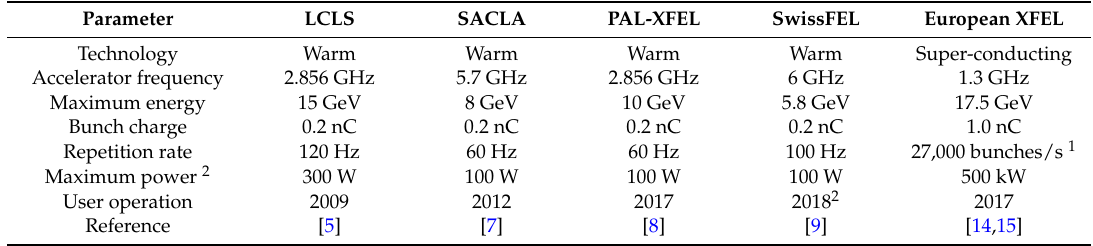
Table 1. Comparison of accelerator parameters of hard X-ray FEL